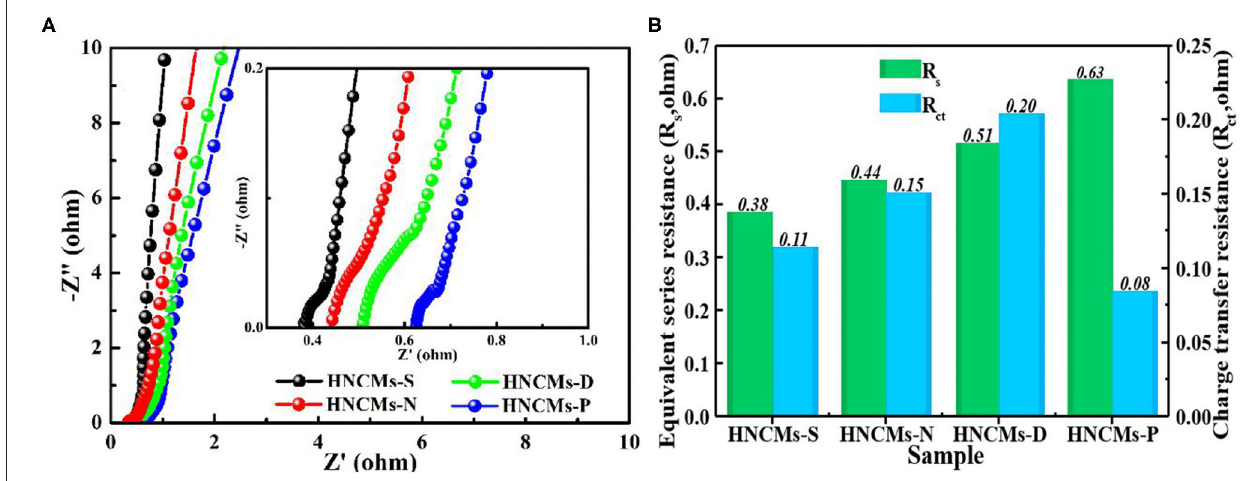
FIGURE 6 | (A) Nyquist plots of HNCM electrodes and the inset image shows the magnified curve in the high-frequency region. (B) R s and R ct values of the HNCM electrodes.